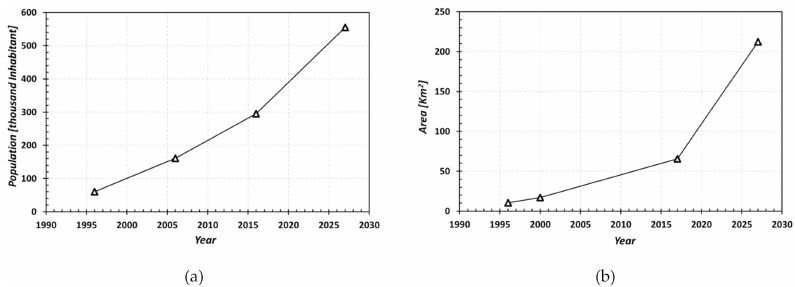
Figure 2. ( a ) Population growth and ( b ) urban expansion in Hurghada between 1996 and